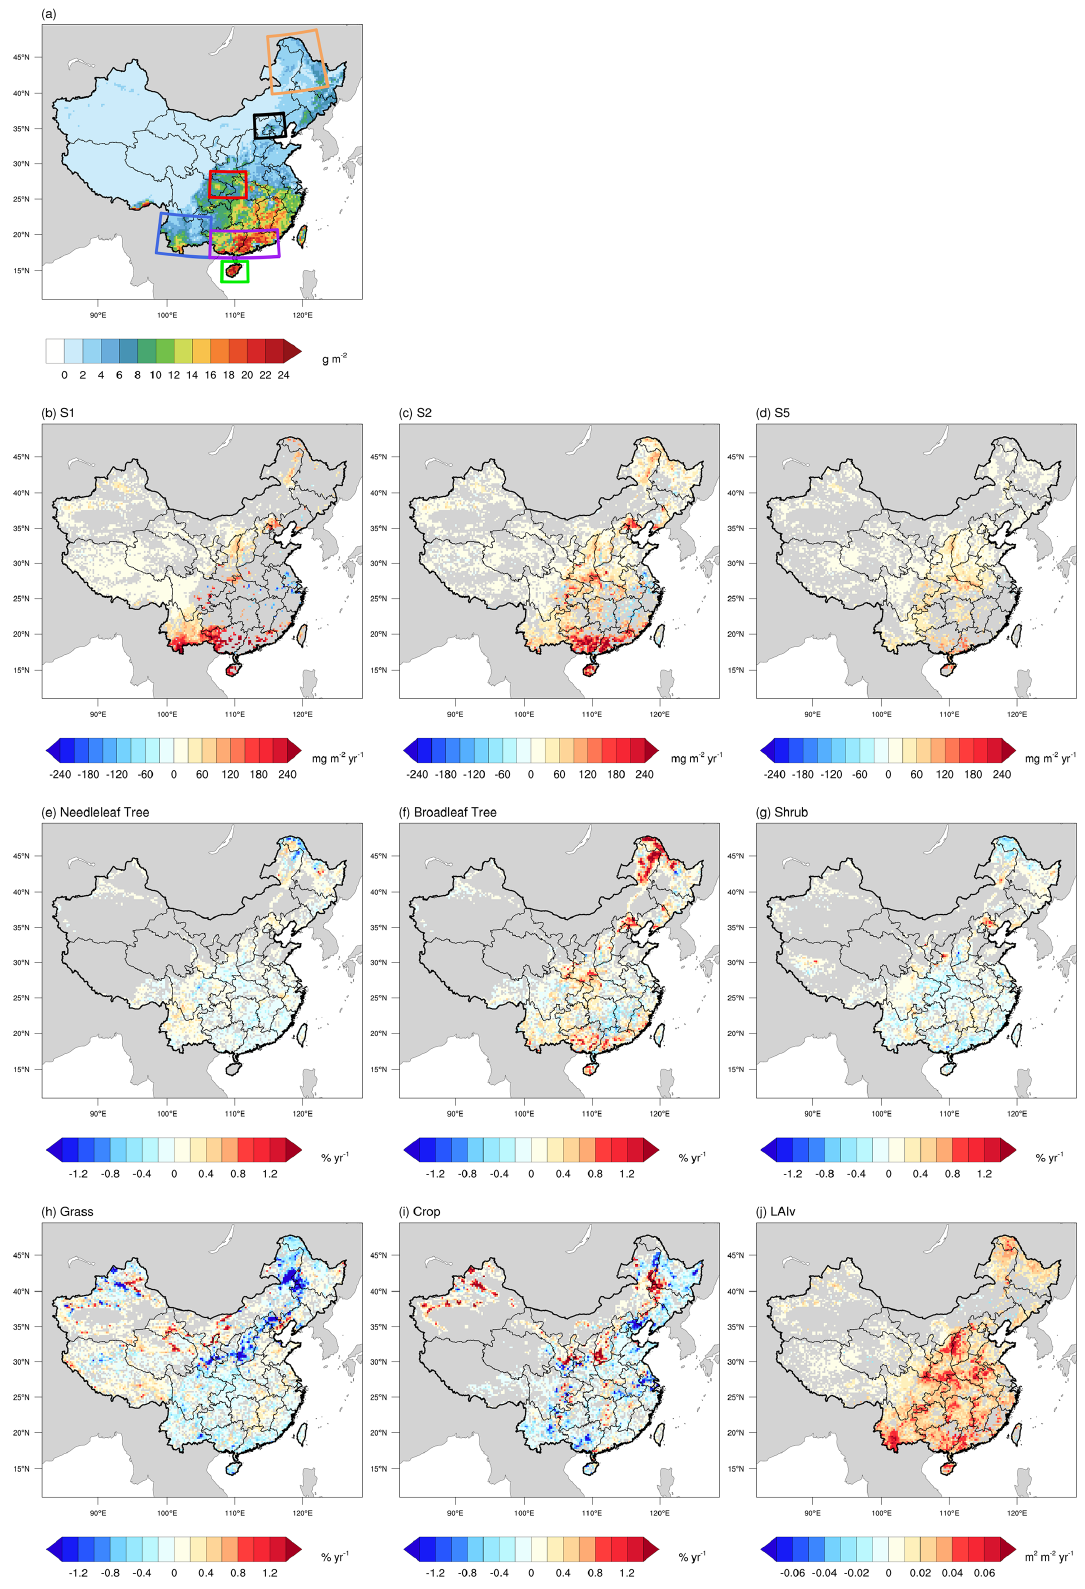
Figure 6. Spatial distribution of total BVOC emission in 2001 (a) and the changing trends of annual emission flux (S1, S2 and S5) and cover fractions of the main PFTs and LAIv. The Mann–Kendall test was used to filter the grids where p is greater than 0.1. https://doi.org/10.5194/acp-21-4825-2021 Atmos. Chem. Phys., 21, 4825–4848,